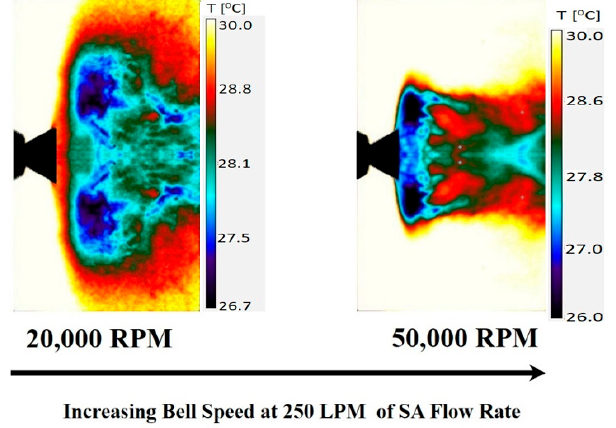
Figure 10. Infrared images of the ERBS Spray, showing changing bell cup rotational speed at a fixed SA flow rate of 250 LPM and a fixed liquid flow rate of 0.1 LPM.